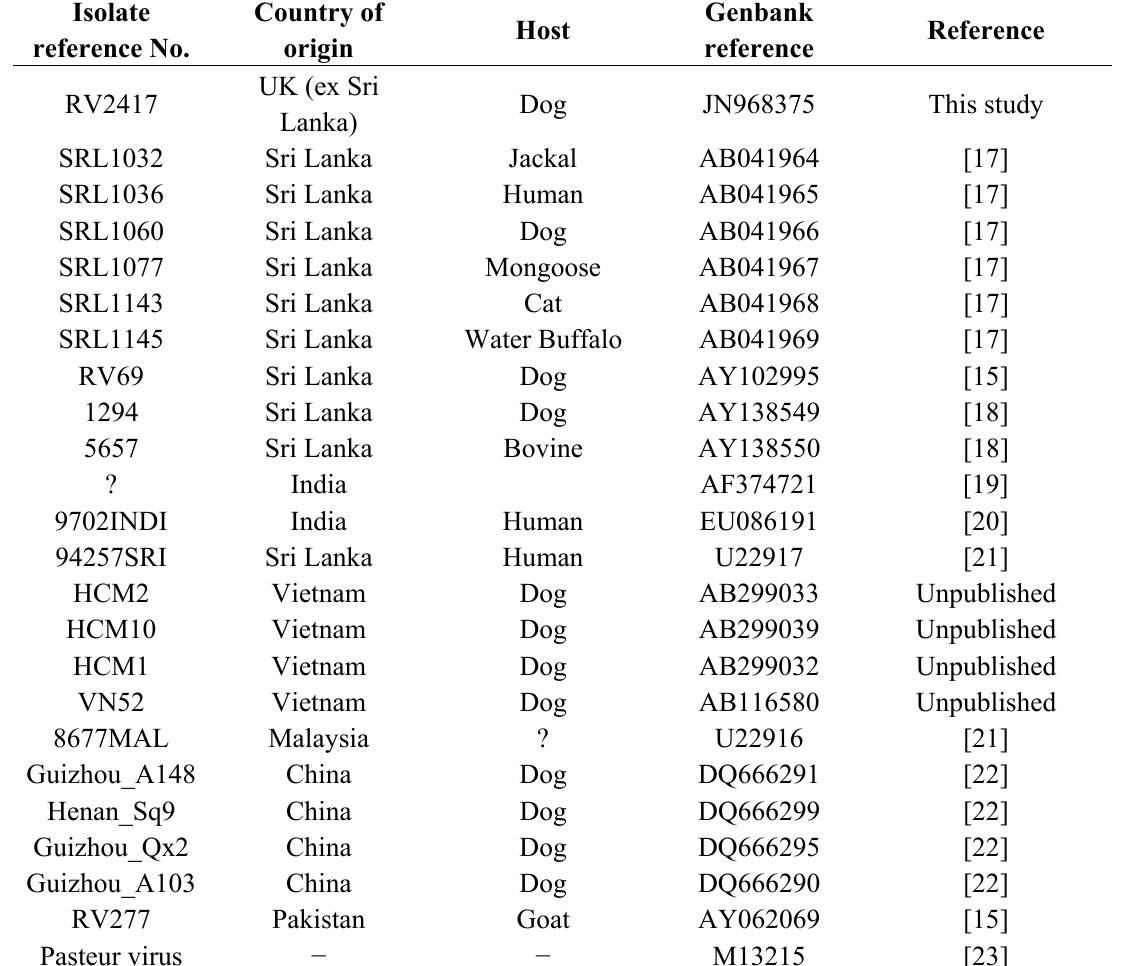
Table 3. Details of rabies virus isolates used in the phylogenetic analysis of the quarantine